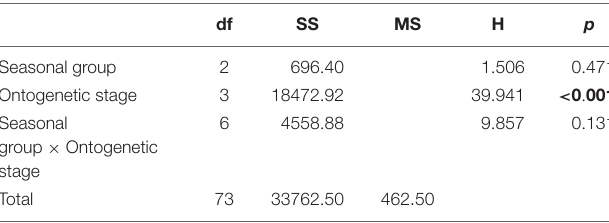
TABLE 2 | Results of non-parametric analysis of variance to test the differences in S. lessoniana statolith oxygen isotopes ratios among seasonal groups